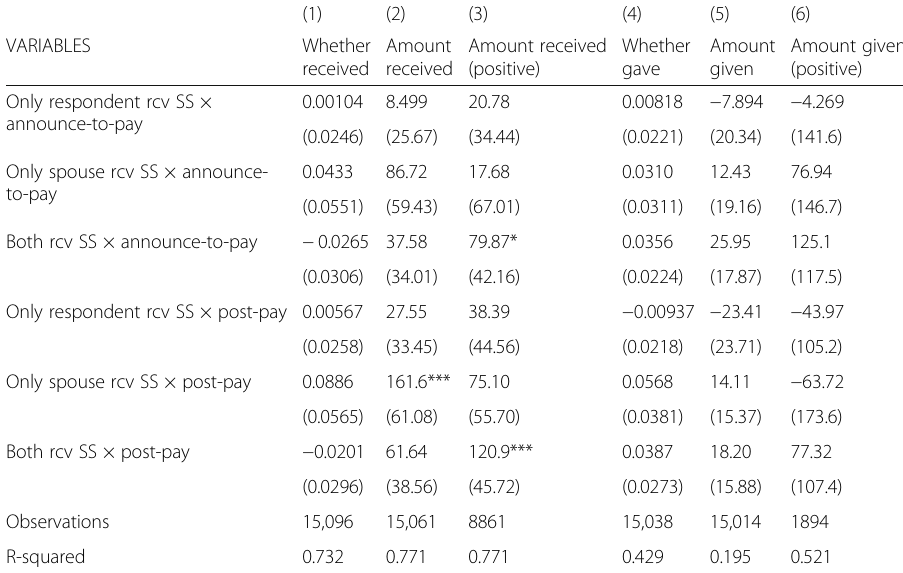
Table 15 Robustness check for private cash transfers — accounting for spousal receipt of SSS payout